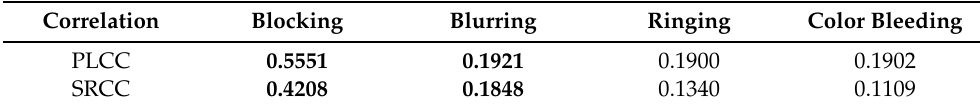
Table 1. Correlation between the PEA intensity and DMOS on the LIVE Video Quality